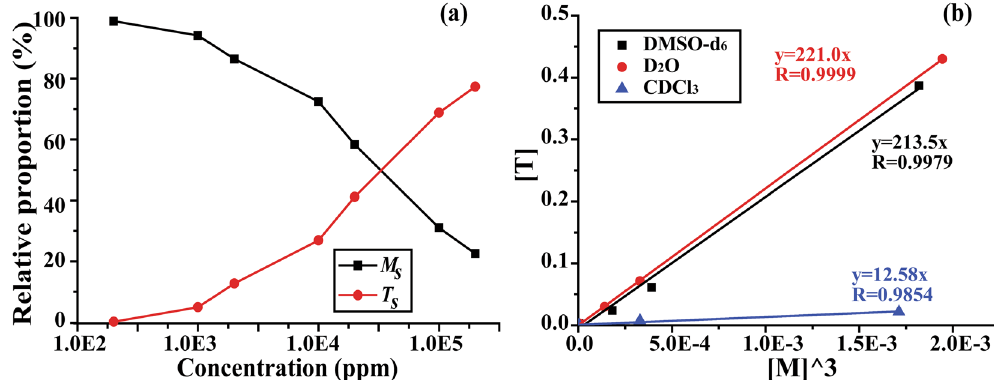
Figure 3. The relative proportion of T s and M s in DMSO- d 6 solution as a function of 1-pyrroline concentration ( a ), and the linear relation between [ T s ] and [ M s ] 3 in different solvents ( b